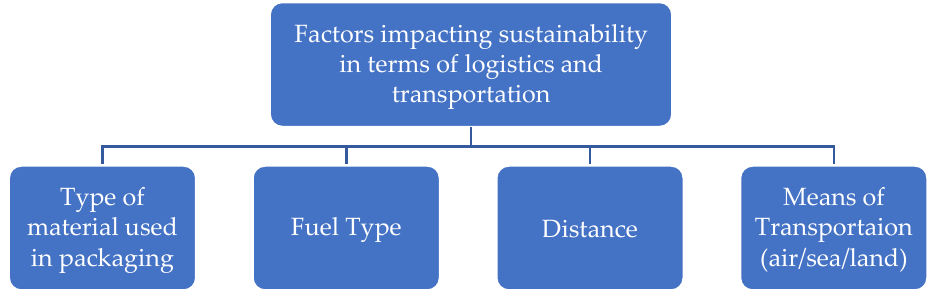
Figure 4. Factors impacting sustainability in terms of logistics and transportation.